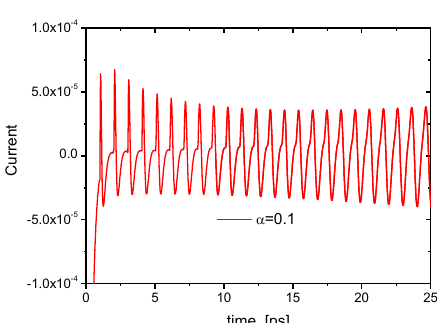
Fig. 5. The developed stage of current oscillations (a.u.) originating from fluctuations of density in the channel. Quite non-harmonic oscillations with slowly varying amplitude are visible.